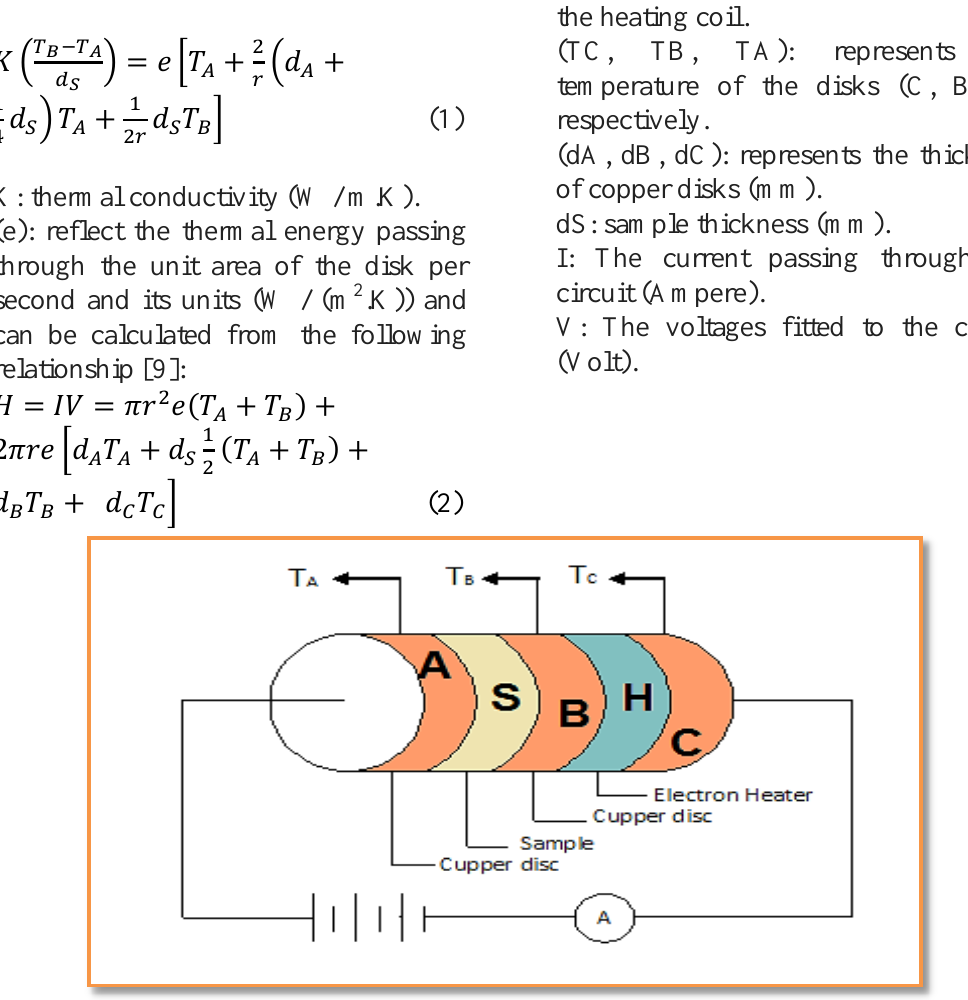
Fig.1: Scheme thermal conductivity